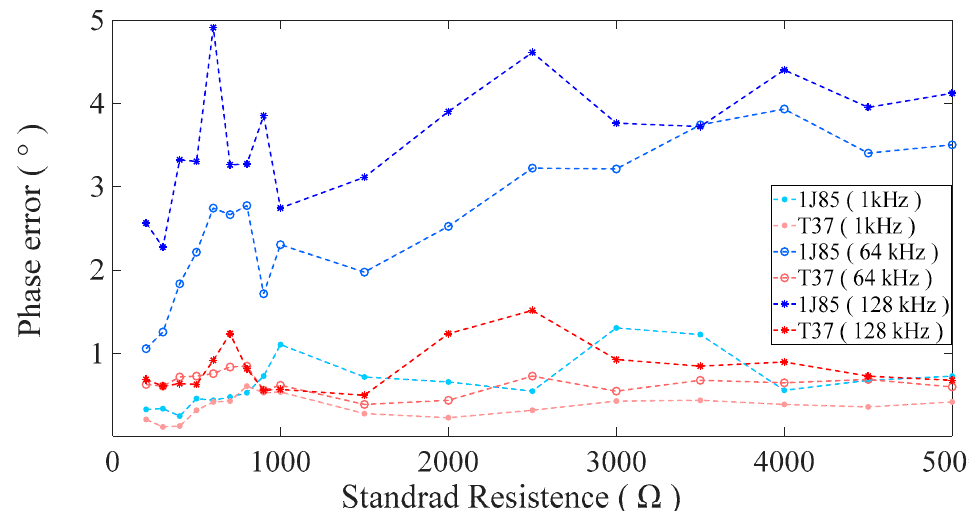
Figure 6. Phase errors of different sensors under different frequencies.